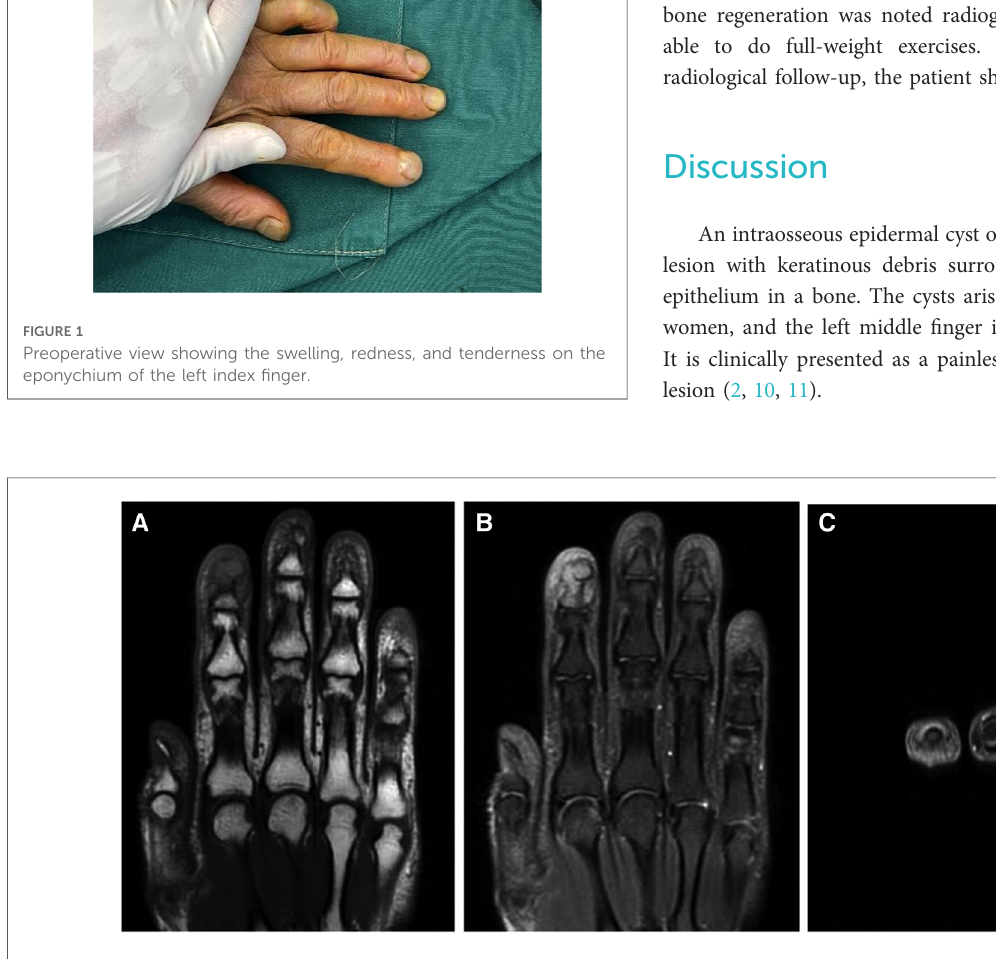
FIGURE 2 MRI of the distal phalanx of the left index fi nger. T1 ( A ) and T2 ( B,C ) showing a well-de fi ned osteolytic lesion with a clear